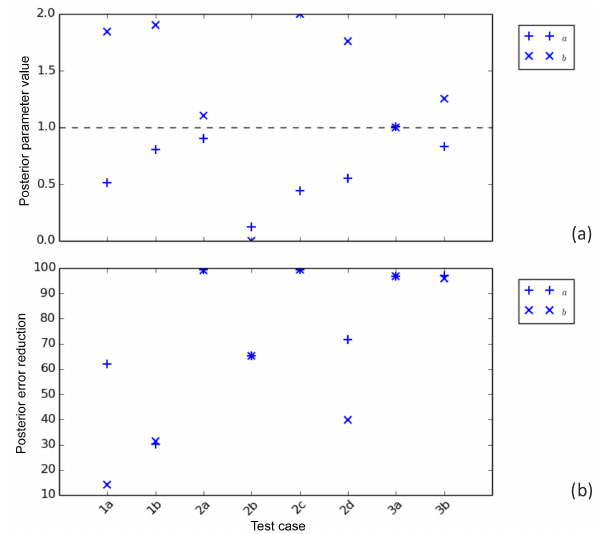
Figure 4. Posterior parameter values of both the non-linear toy model a and b parameters for each test case for the simulations with no model bias. The y axis range corresponds to the parameter bounds, and the dashed horizontal line represents the “true” known value of both parameters. To give an indication of the optimisation performance, the following are the first-guess parameter values for this particular example test (compare with posterior values in a ): a 0.87, b 1.98. (b) Posterior uncertainty reduction for both parame- ters for all test